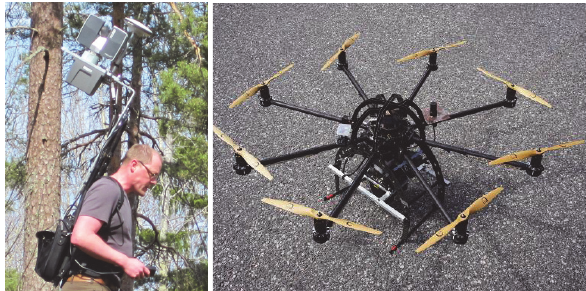
Figure 1. The backpack laser scanner (AkhkaR2) and the UAV- operated laser scanning system.